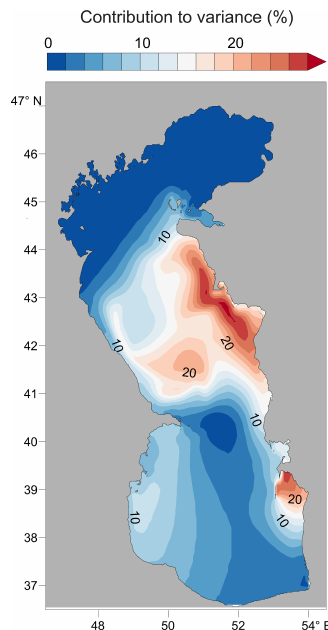
Figure 4. (a) Form factor and (b) the maximal tidal range in the Caspian Sea. Figure 5. The relative contribution (in percent) of the tides to the total sea level variance in the Caspian Sea in the frequency band from 0.1 to